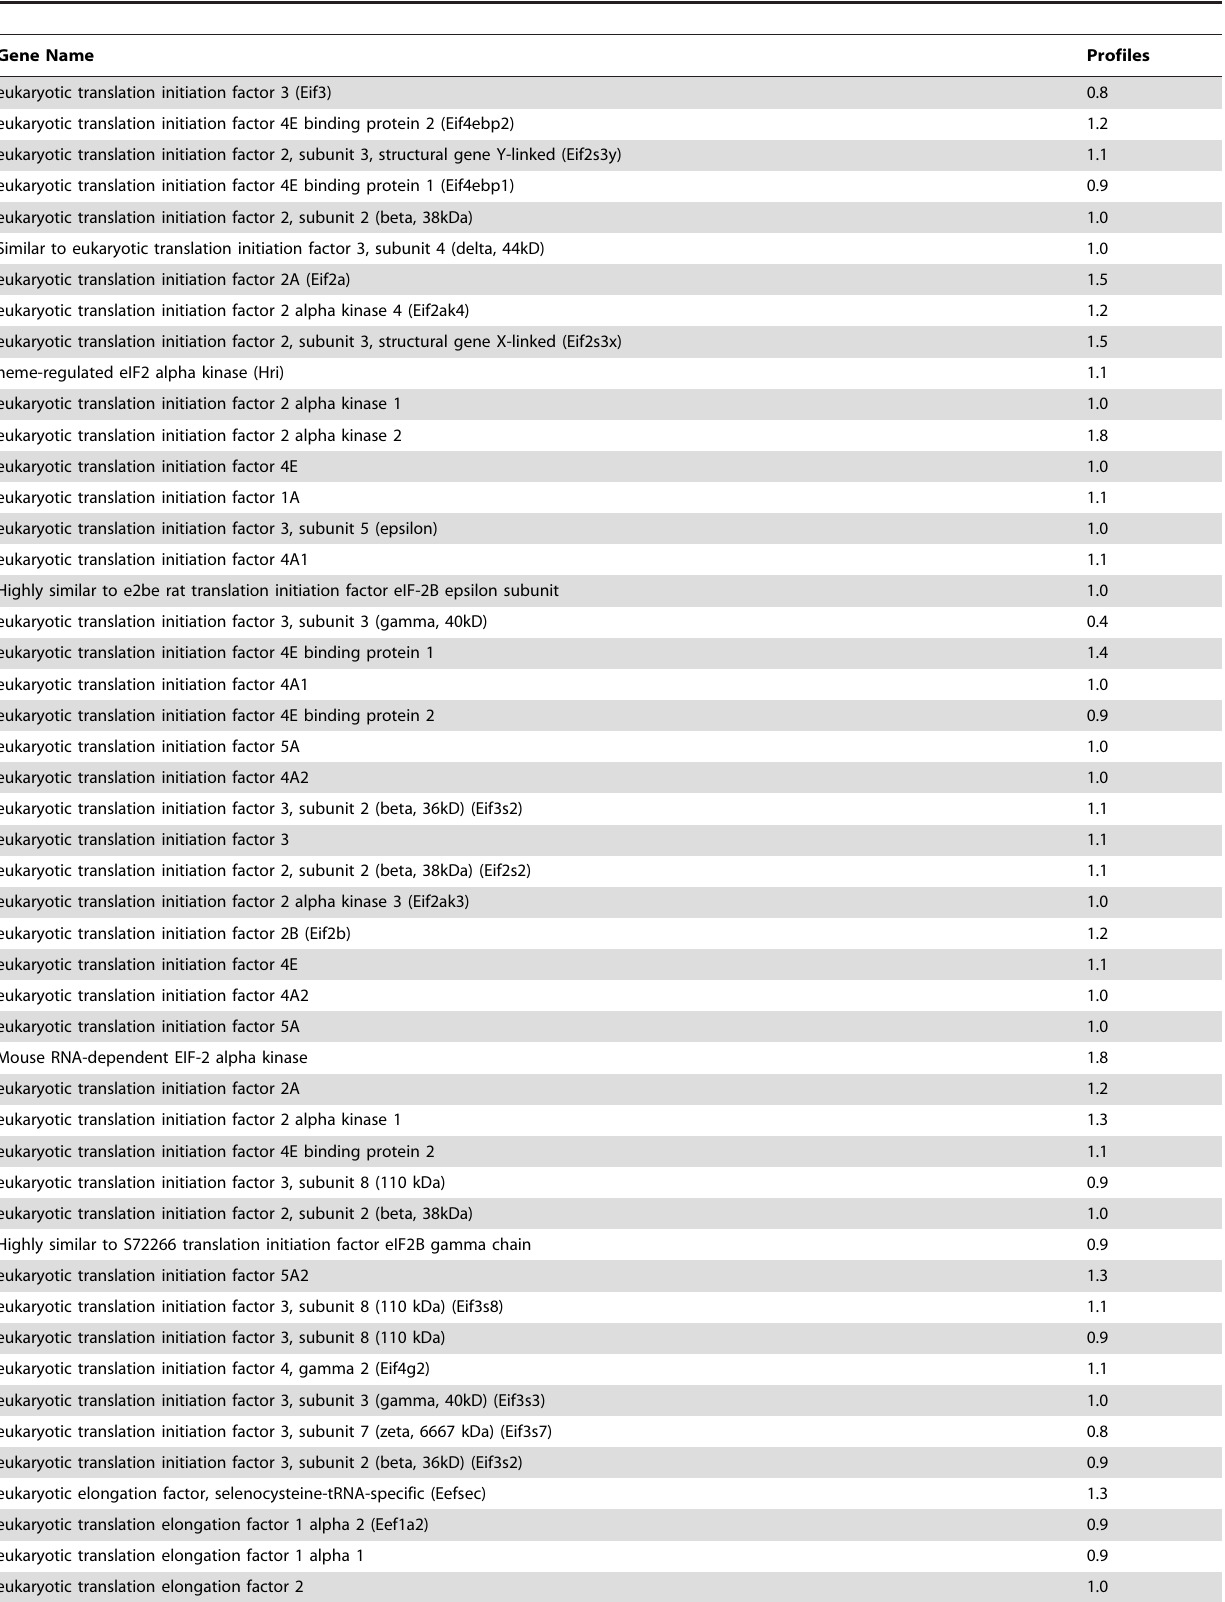
Table 1. Expression profiles of translational molecules and their related molecules in the hippocampus of B6/CBA F1 mice after training in a fear-conditioning